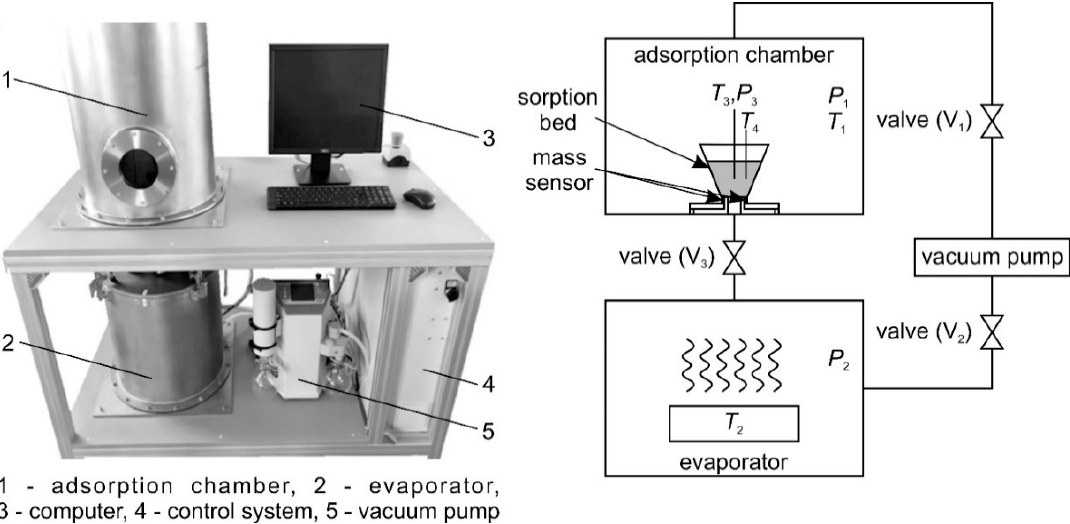
Figure 2. The testing stand and diagram of the test stand.